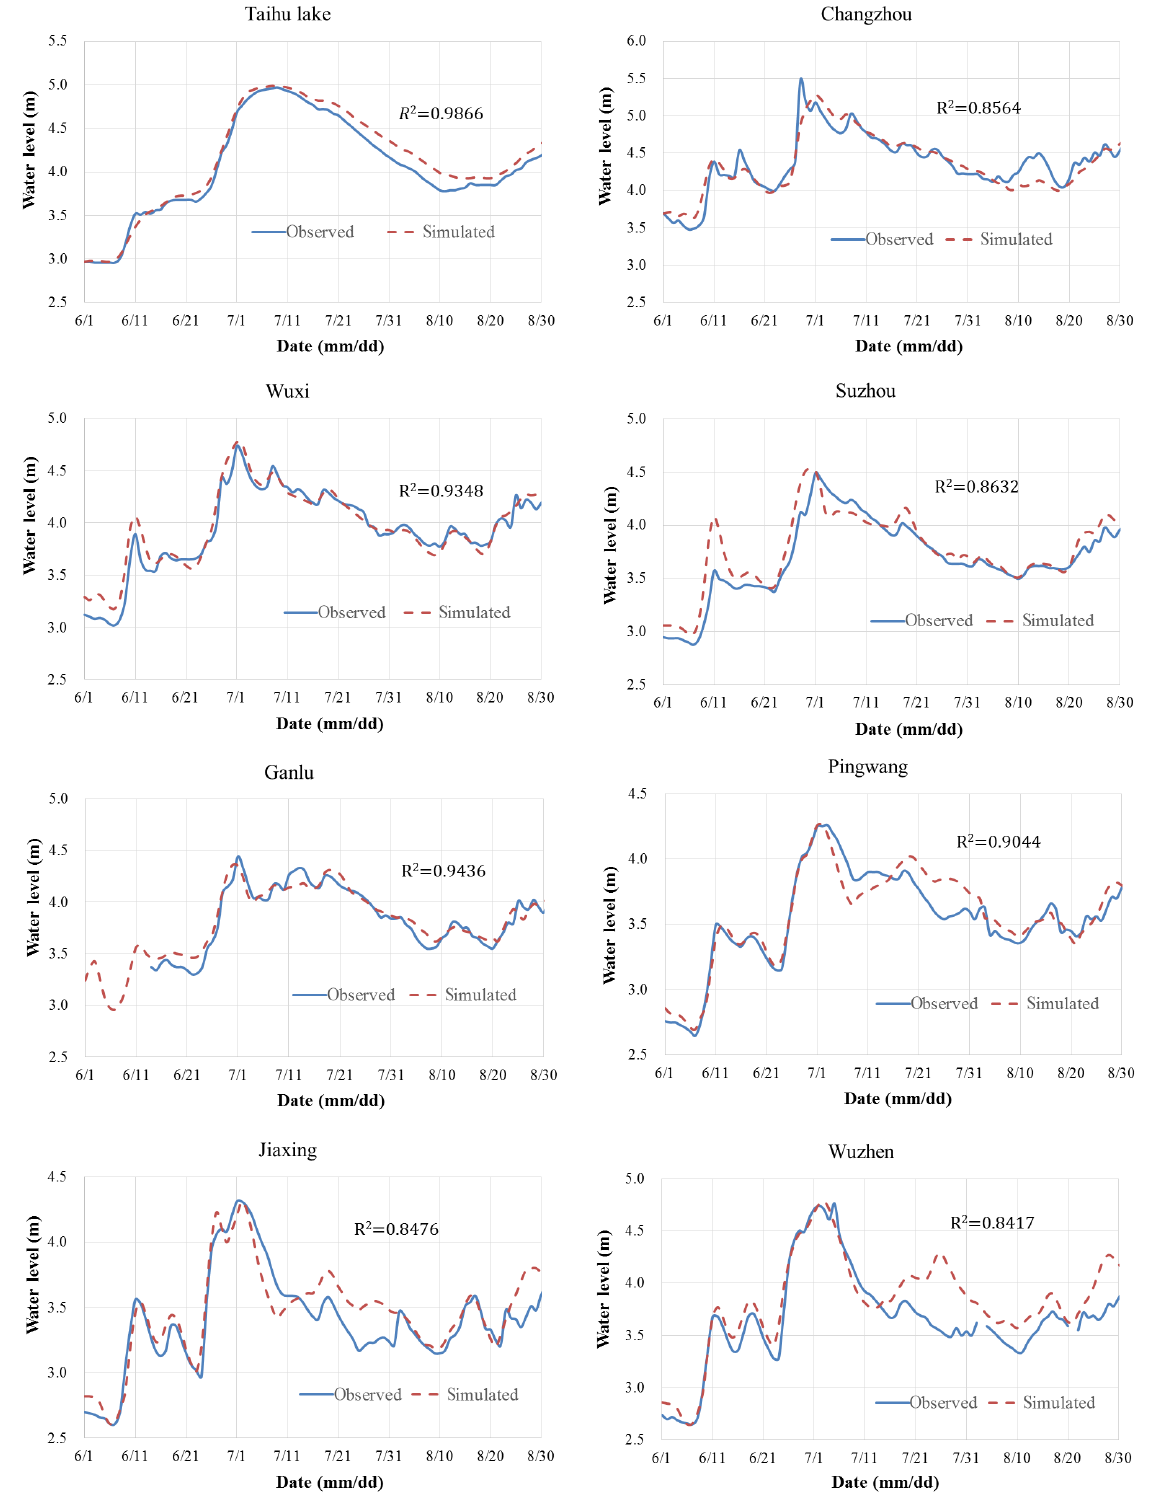
Figure 3. Comparison between the observed and simulated water levels from June to August in the 1999 flood event at eight stations as shown in Fig. 1 (adapted from Ou and Wu,